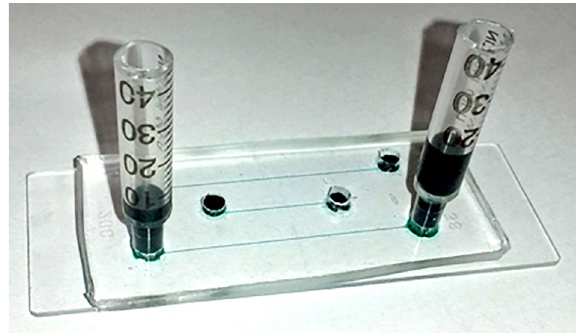
Figure 1. The researchers applied hydrostatic pressure to create a fluid flow inside themicrochannel where sperm rheotaxis was studied. Microchannels with dimensions of 200 μm × 20 μm (W × H) and a length of 3.6 μm were employed. Themicrochannel in between reservoirs with syringes mounted at ends were used. To make the channel more visible, food colours were